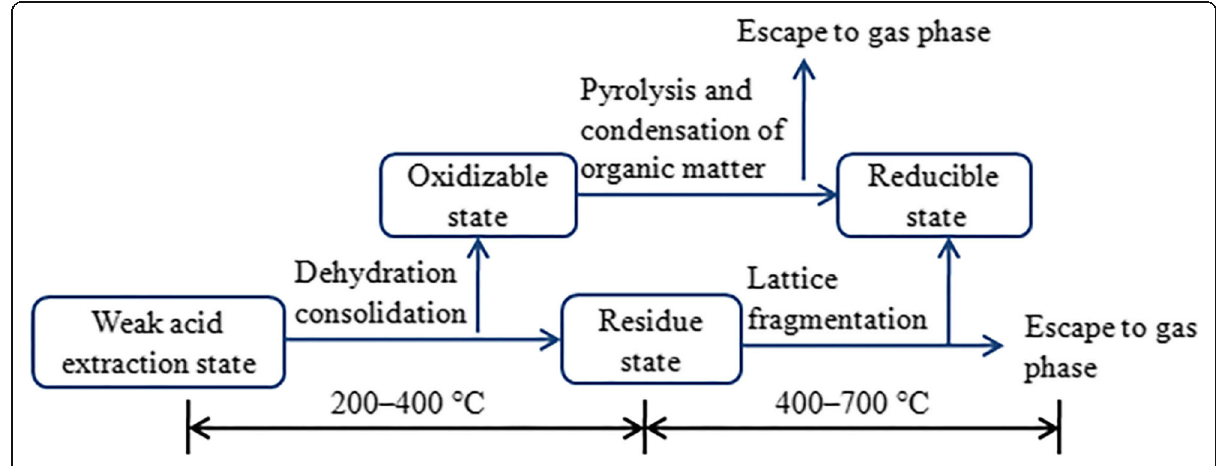
Fig. 5 A schematic diagram of metal migration in the pyrolysis process